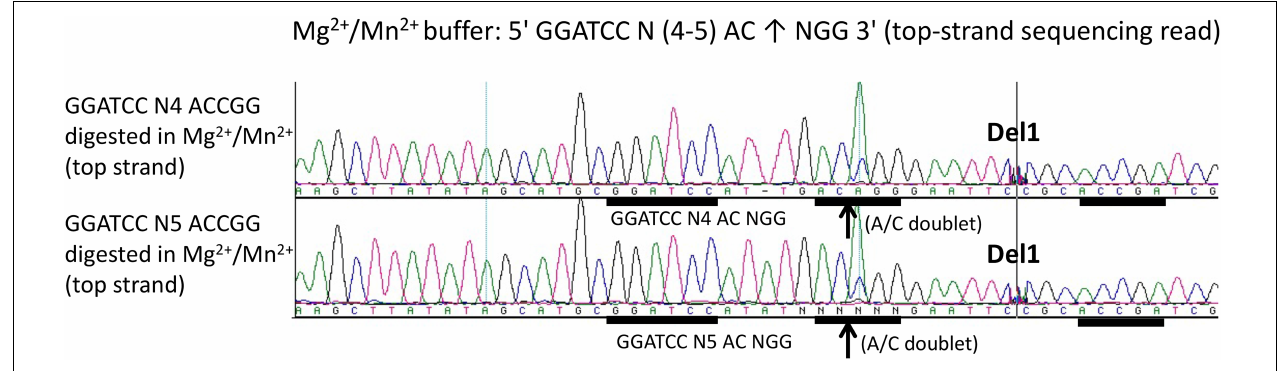
FIGURE 4 | DNA run-off sequencing to map the nicking site and nicking distance from Bam HI in the engineered composite site GGATCC-N(4-5)-AC ↑ CGG in pUC19 (1xACCGG). Top-strand sequencing read using nicked bottom-strand template. DNA nicking reactions were carried out in NEB buffer 2 supplemented with Mn 2 + (1 mM) at 37 ◦ C for 30 min. The up arrows indicate the nicked position where a strong A/C doublet was present. Del1 indicates the intervening sequence had been manually deleted to show the downstream site ACCGA (where no nicking had occurred). The composite sites GGATCC N4 ACCGG and GGATCC N5 ACCGG were inserted into pUC19 multiple cloning sites and flanked by Hin dIII and Eco RI sites. In addition, a star site (AGTCG) upstream of the Bam HI site was changed to the sequence TATAG to eliminate the star nicking